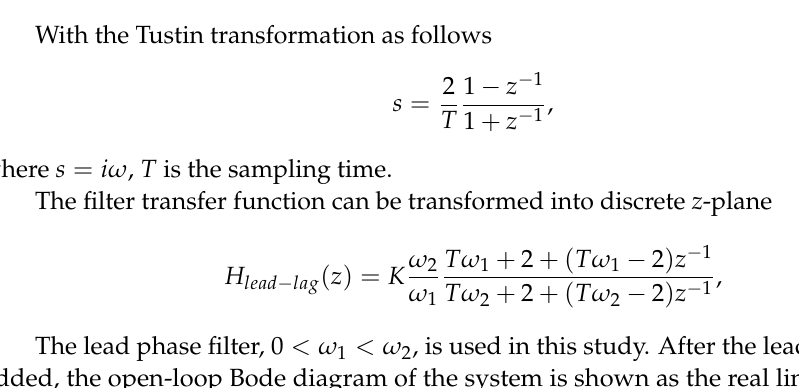
Figure 4. Bode diagram of open-loop and close-loop.